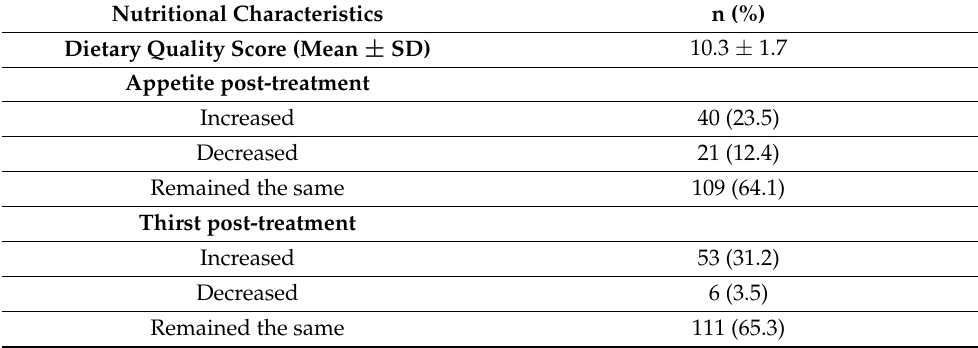
Table 2. Nutritional characteristics, food changes and supplementation